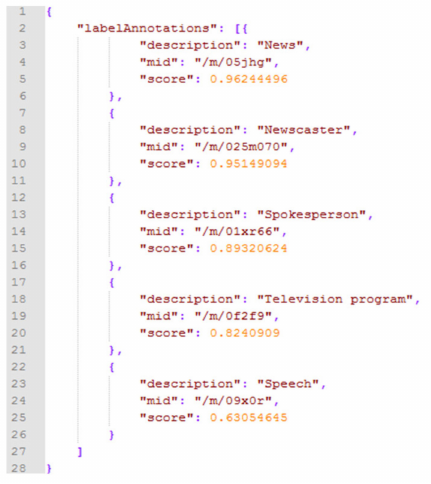
Figure 3. The top 5 labels of Figure 2 assigned by Google Cloud Vision API.